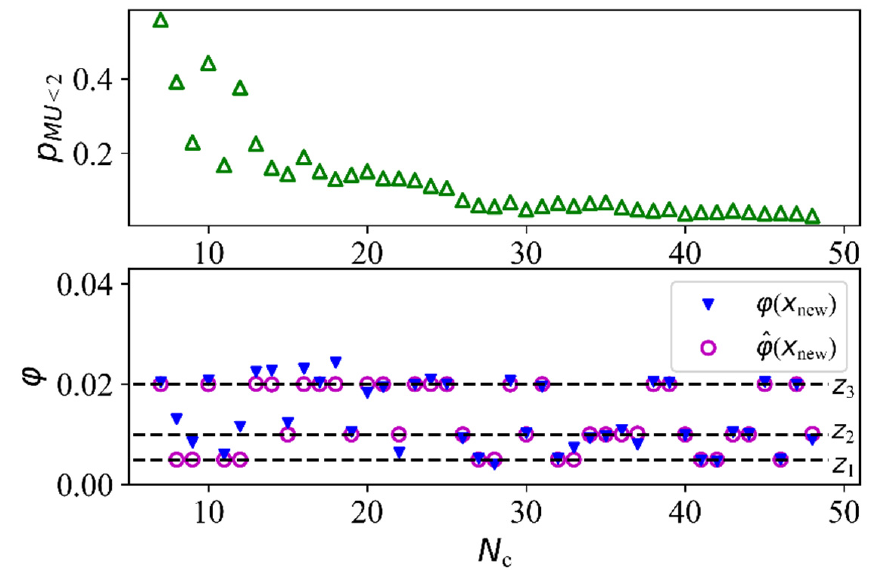
Figure 6. The seismic demand of the added samples.